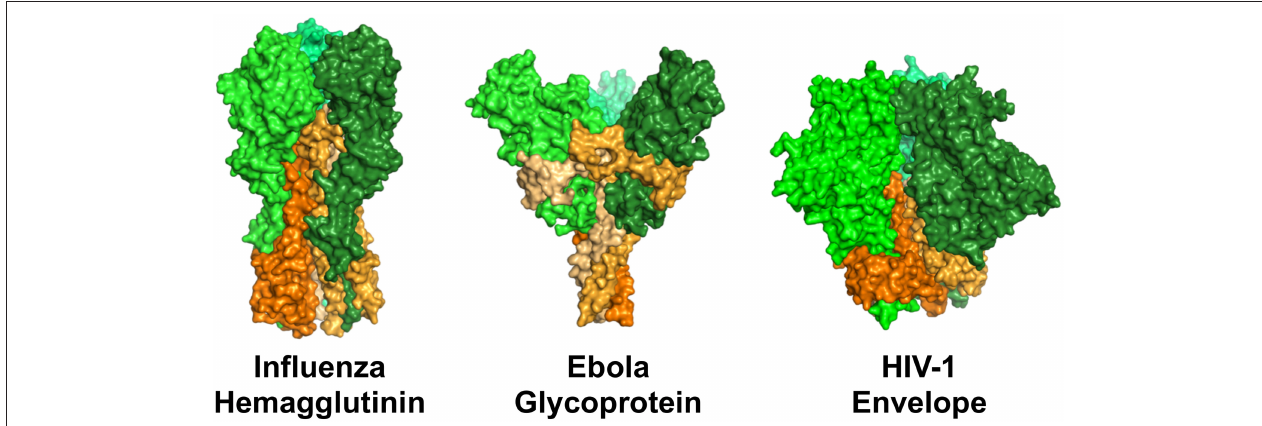
FIGURE 3 | Surface representation of structures of the viral fusion proteins of influenza virus, ebola virus, and HIV-1 that are targets of antiviral antibodies. Perspective is from the side, such that the proteins are standing atop the virus envelope. These envelope proteins share a general structural architecture as trimers of dimeric proteins comprised of a receptor binding domain (head, represented by shades of green) and a viral membrane-bound domain (stem/stalk, represented by shades of orange). Renderings were made in PyMOL using protein data bank ID 3GBN (influenza), 5JQ3 (ebola), and 5FYL